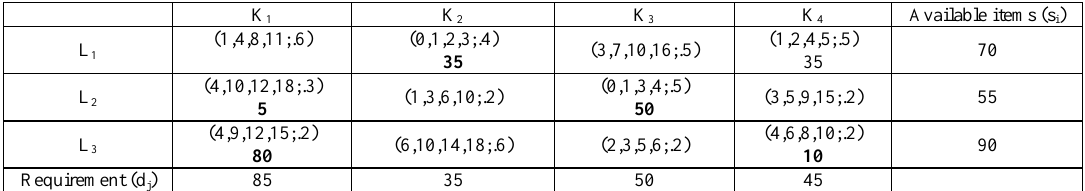
Table 6. Initial Basic Feasible Solution